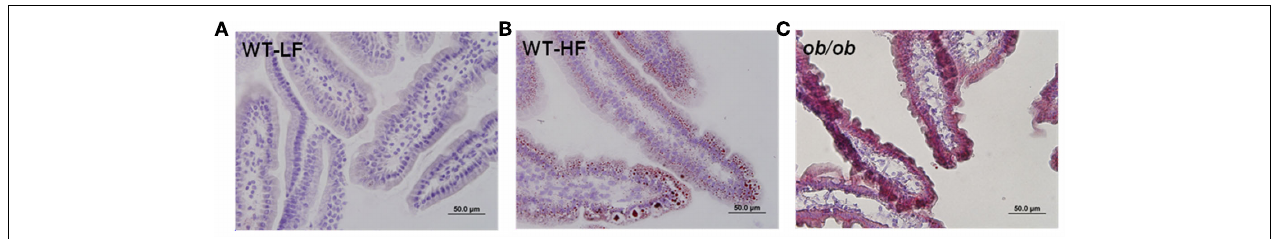
FIGURE 3 | Lipid accumulation in fed state proximal intestinal mucosa. (A) LF-fedWT mice (B) HF fedWT mice (C) LF-fed ob/ob mice. 40 × magnification, 10 μ m section, ORO, and H&E stain, as described in Section “Materials and Methods.”